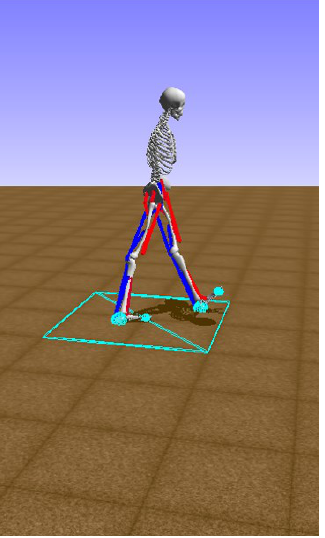
Figure 3. The lower limb musculoskeletal